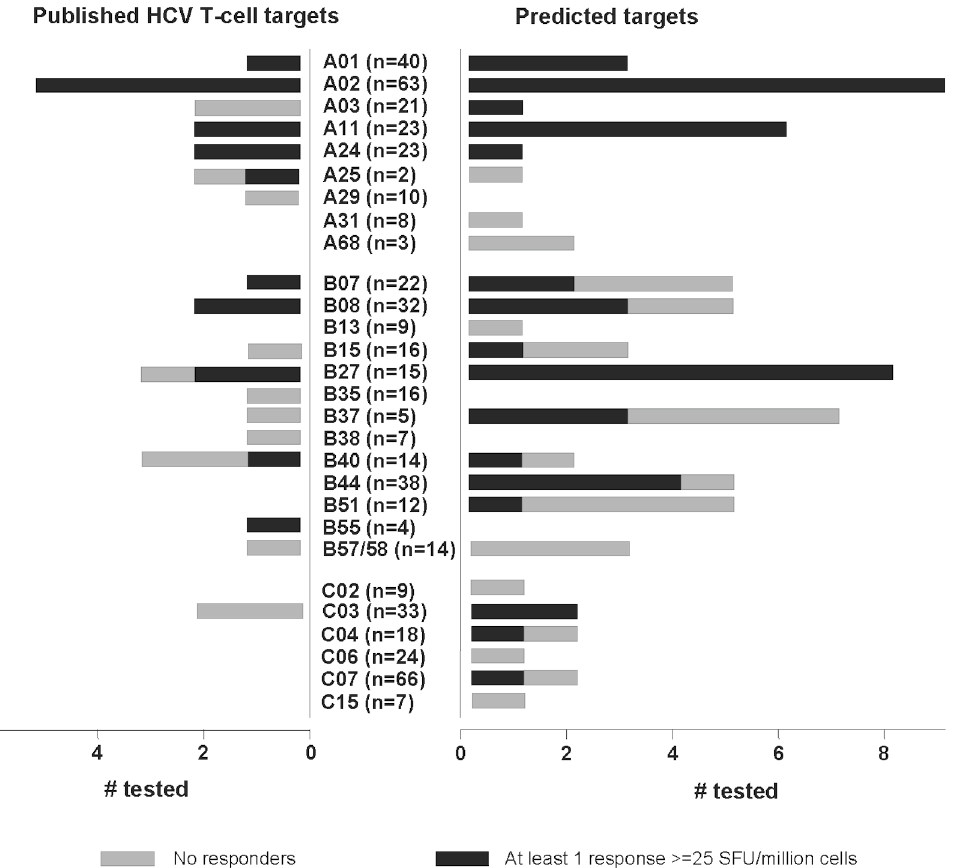
Fig 1. Breakdown of HLA-specific T-cell targets tested and number eliciting a T-cell response based on an IFN- γ ELISpot assay. Predicted T-cell targets include published HCV T-cell targets that contain a site associated with a specific HLA allele with the same restriction. Number in bracket indicates number of subjects tested that carry the particular HLA